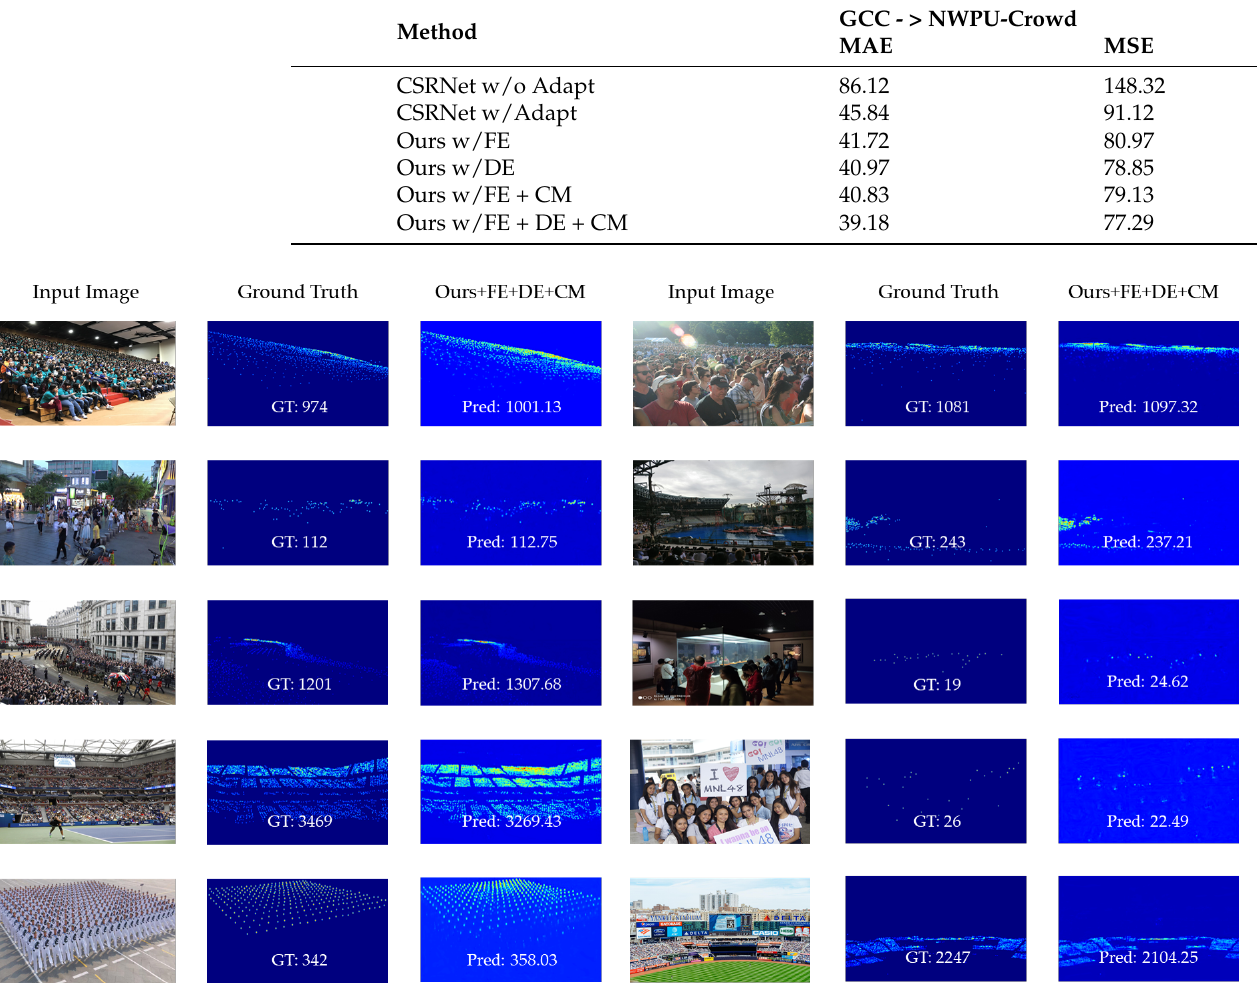
Figure 8. Visualization results of adaptation from GCC to real-world